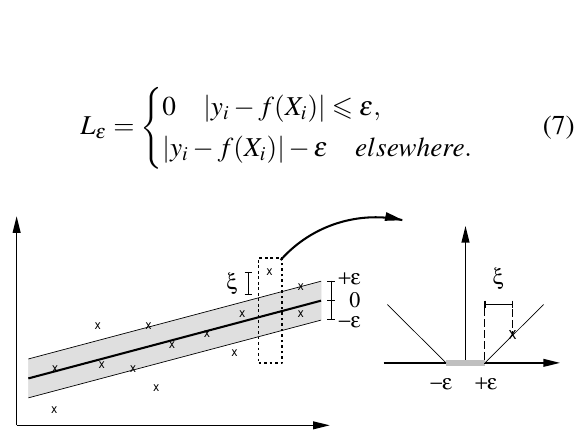
Figure 2: Creation of sample set.